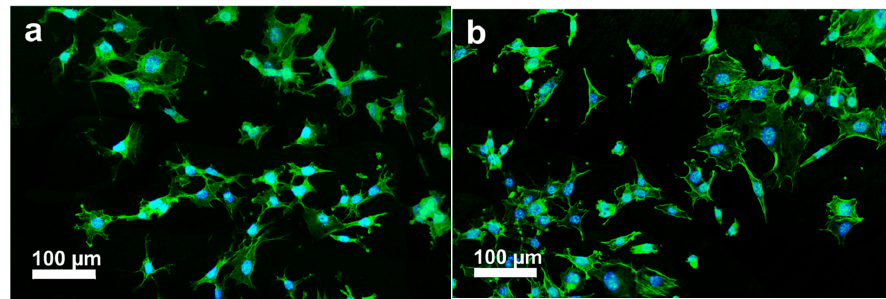
Figure 9. Fluorescence micrographs of osteoblasts cultured on ( a ) PEEK/(0.93% MWNT) and ( b ) PEEK/(1.88% MWNT) nanocomposites and stained for F-actin cytoskeleton (green) and nucleus (blue) for 3 days.